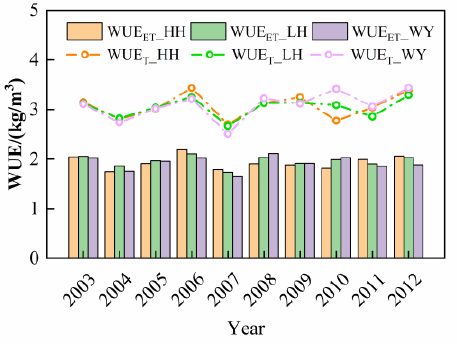
Figure 9. Average WUE of maize in three counties during the study